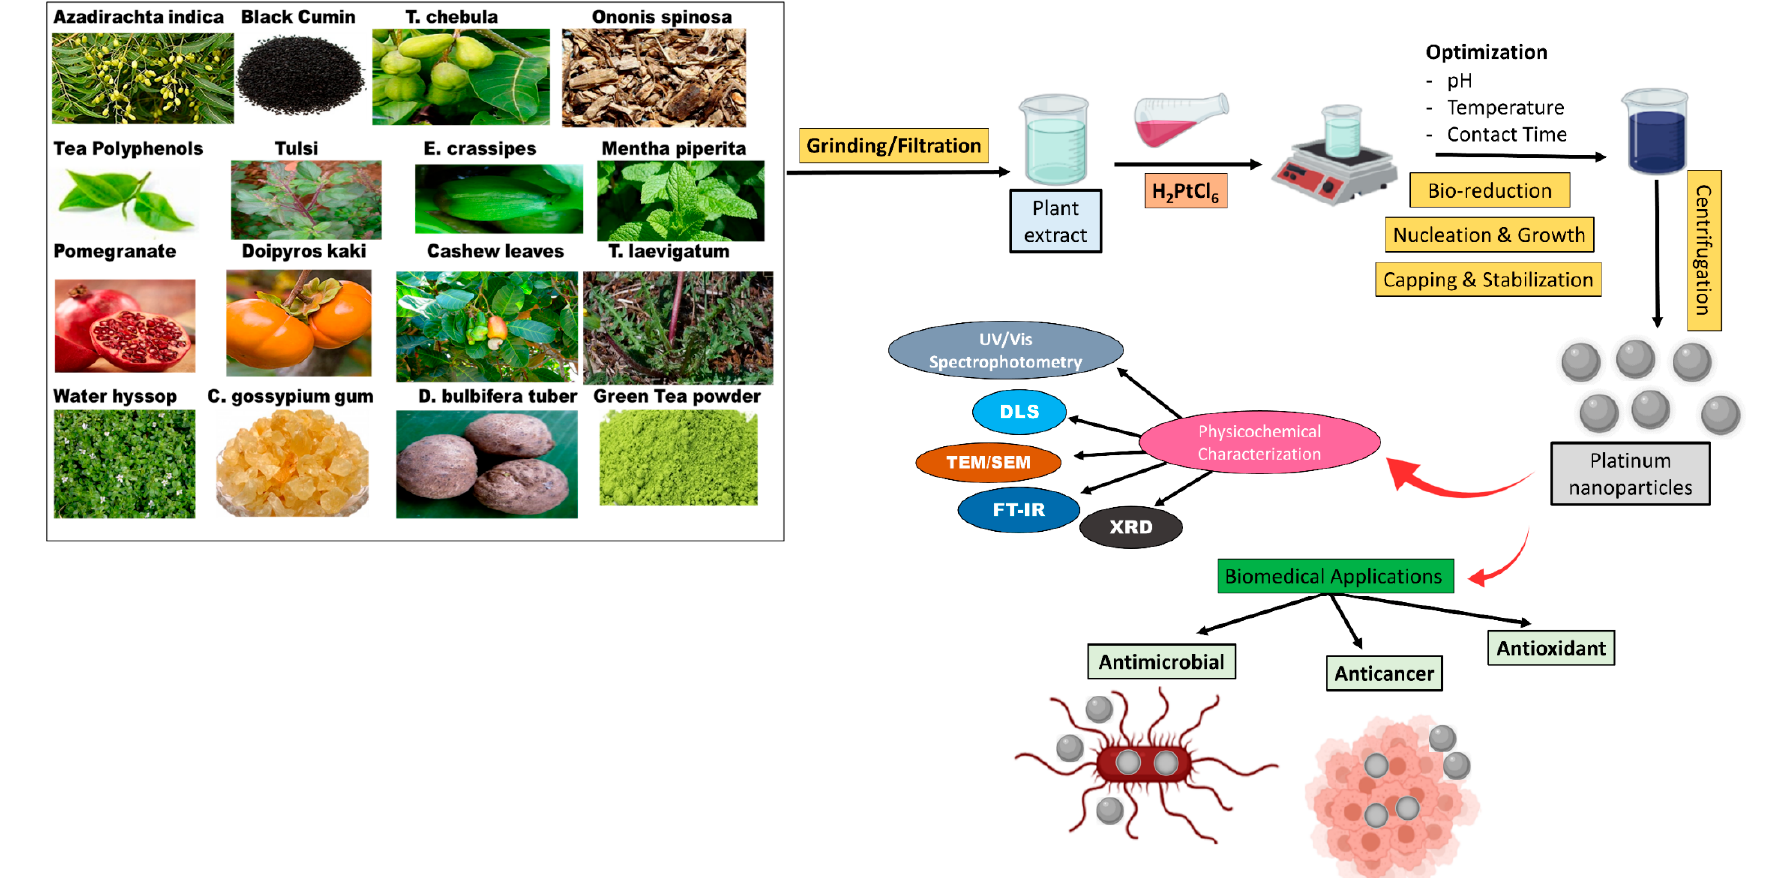
Figure 1. Schematic diagram summarizing the plant species employed in the bio-reduction of PtNPs, parameters optimized, and the techniques employed for characterization of the synthesized nanoparticles.